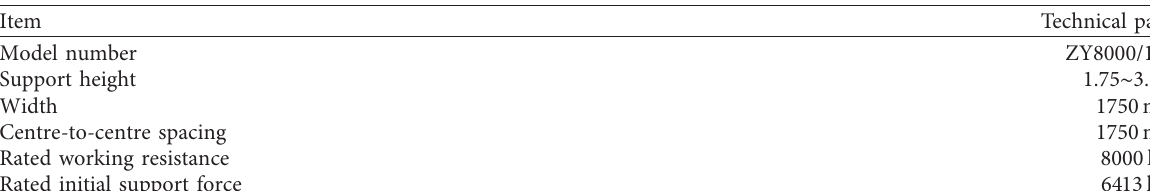
Table 2: Shield technical parameters.